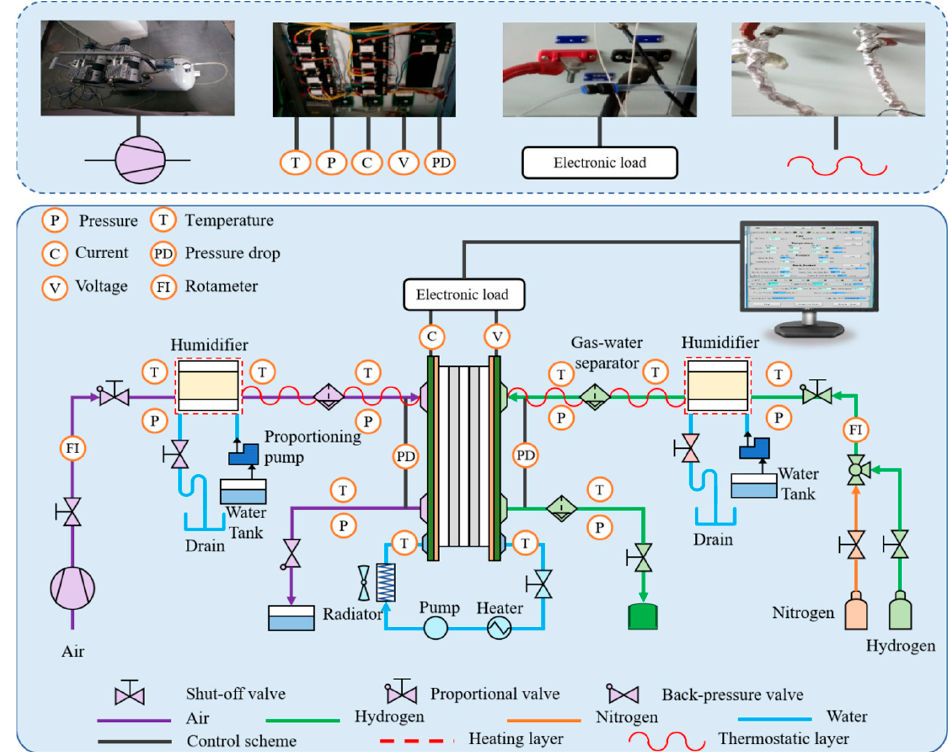
Figure 3. Schematic diagram of the test system. Table 4. Parameters of the single fuel